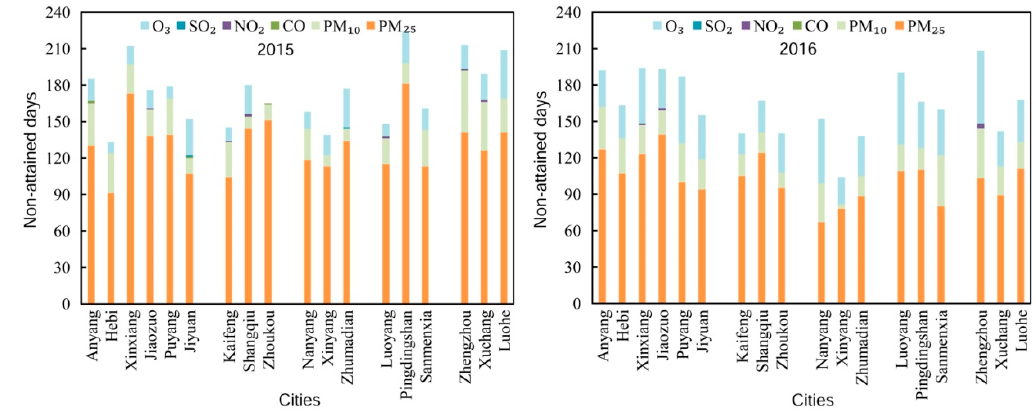
Figure 5. Contributions of the six pollutants as the major pollutant on non-attainment days at the city scale in 2015–2016.